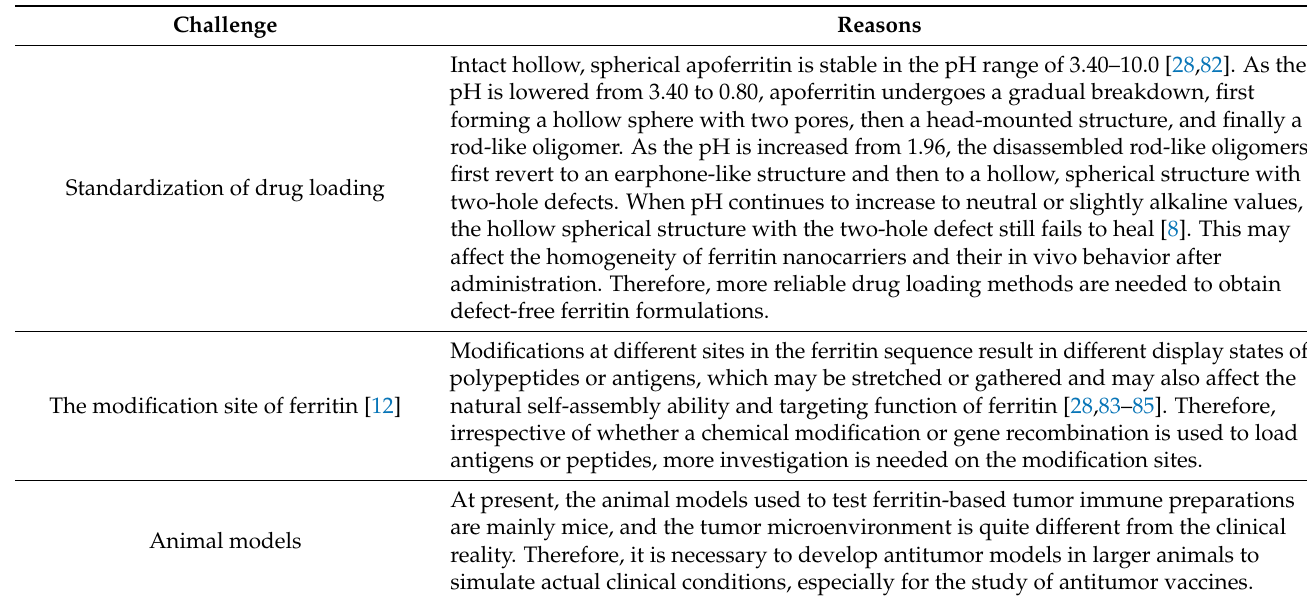
Table 2. The key obstacles for ferritin-based clinical